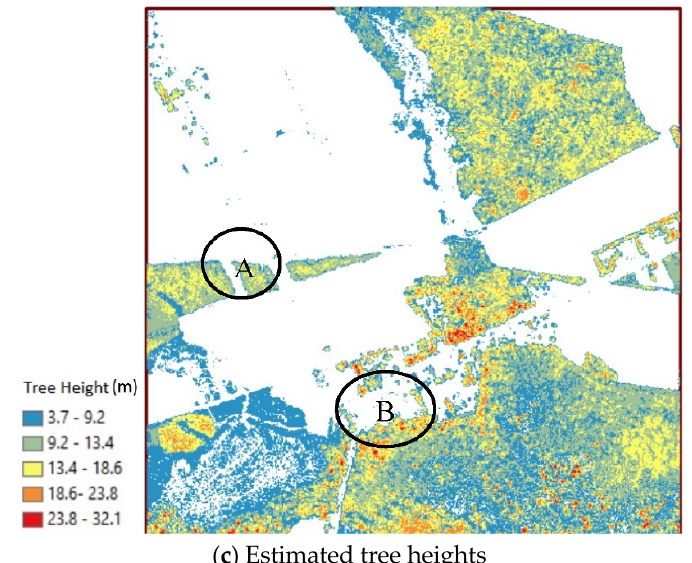
Figure 4. Study area: ( a ) ground surface or DTM, ( b ) digital surface model, ( c ) tree heights. A and B are the examples of the areas within the study region for which the contribution to the region-total AGFB differs depending on whether CDL- or NLCD-based maps are used.